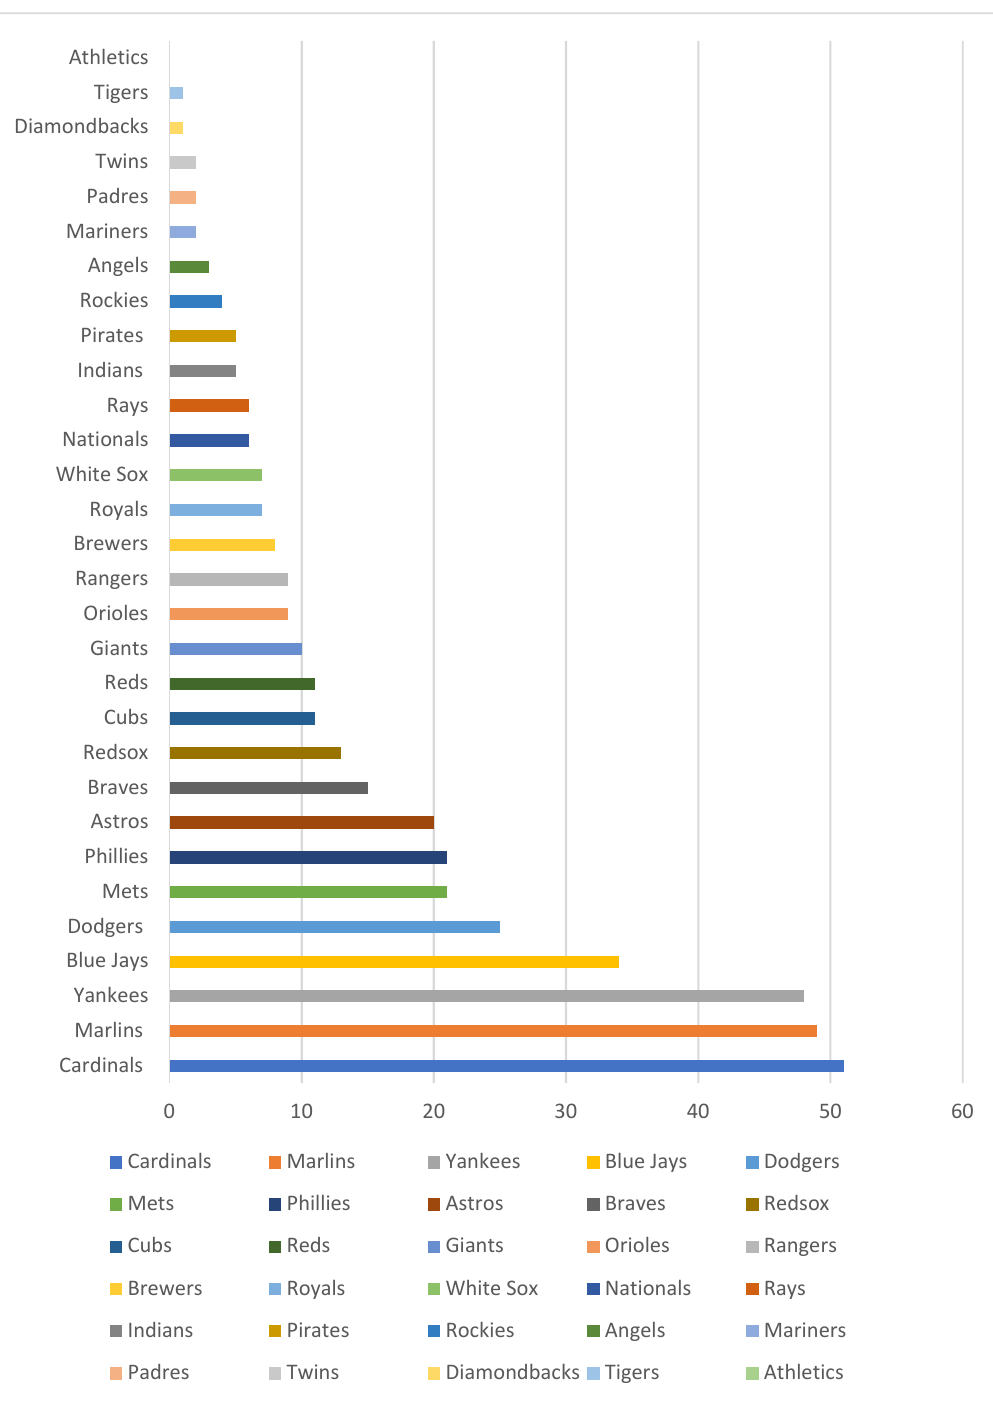
Figure 4. Frequency MLB teams mentioned.